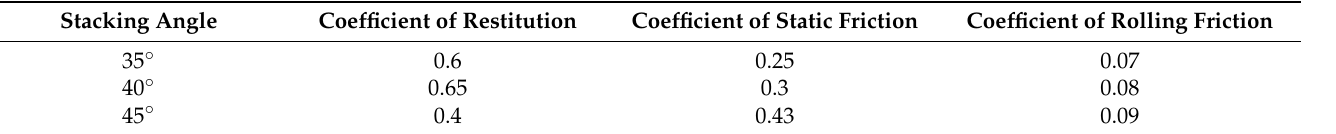
Table 6. Settings of material contact parameters.